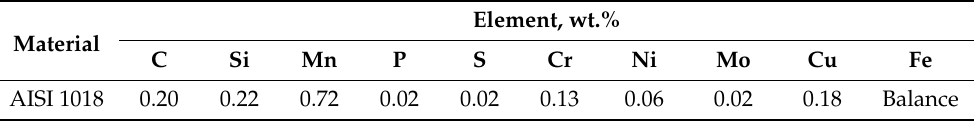
Figure 2. Dimensions of reinforced concrete specimens for electrochemical tests. Table 6. Elemental composition (wt.%) of the AISI 1018 CS reinforcement tested.